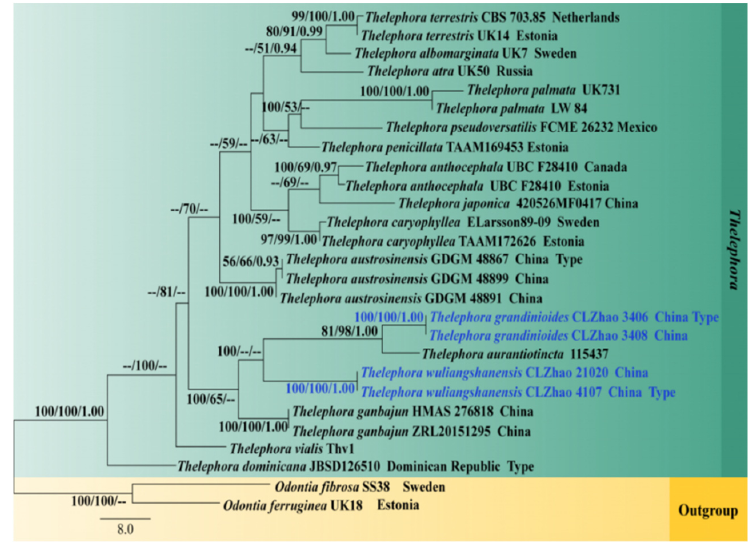
Figure 4. Maximum parsimony strict consensus tree based on the nrLSU sequences. Bootstrap support values for maximum likelihood (ML) equal to or higher than 60%, Bayesian Probability (PP) equal to or higher than 0.90, and maximum parsimony (MP) bootstrap proportions equal to or higher than 50% are mentioned above the branches (MP/ML/PP). Strains of the newly described species are depicted in blue.